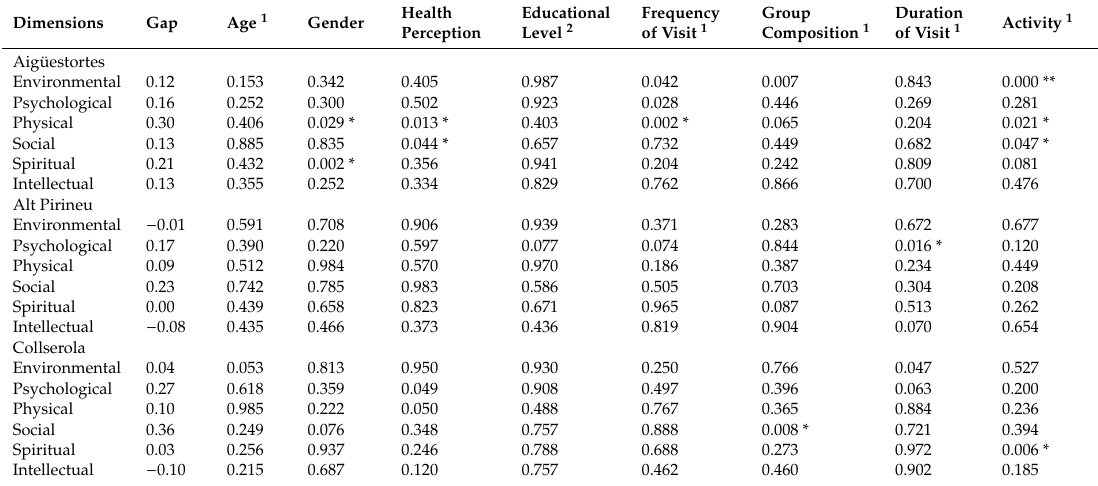
Table 8. Descriptive statistics and test of significance for results of GAP analysis